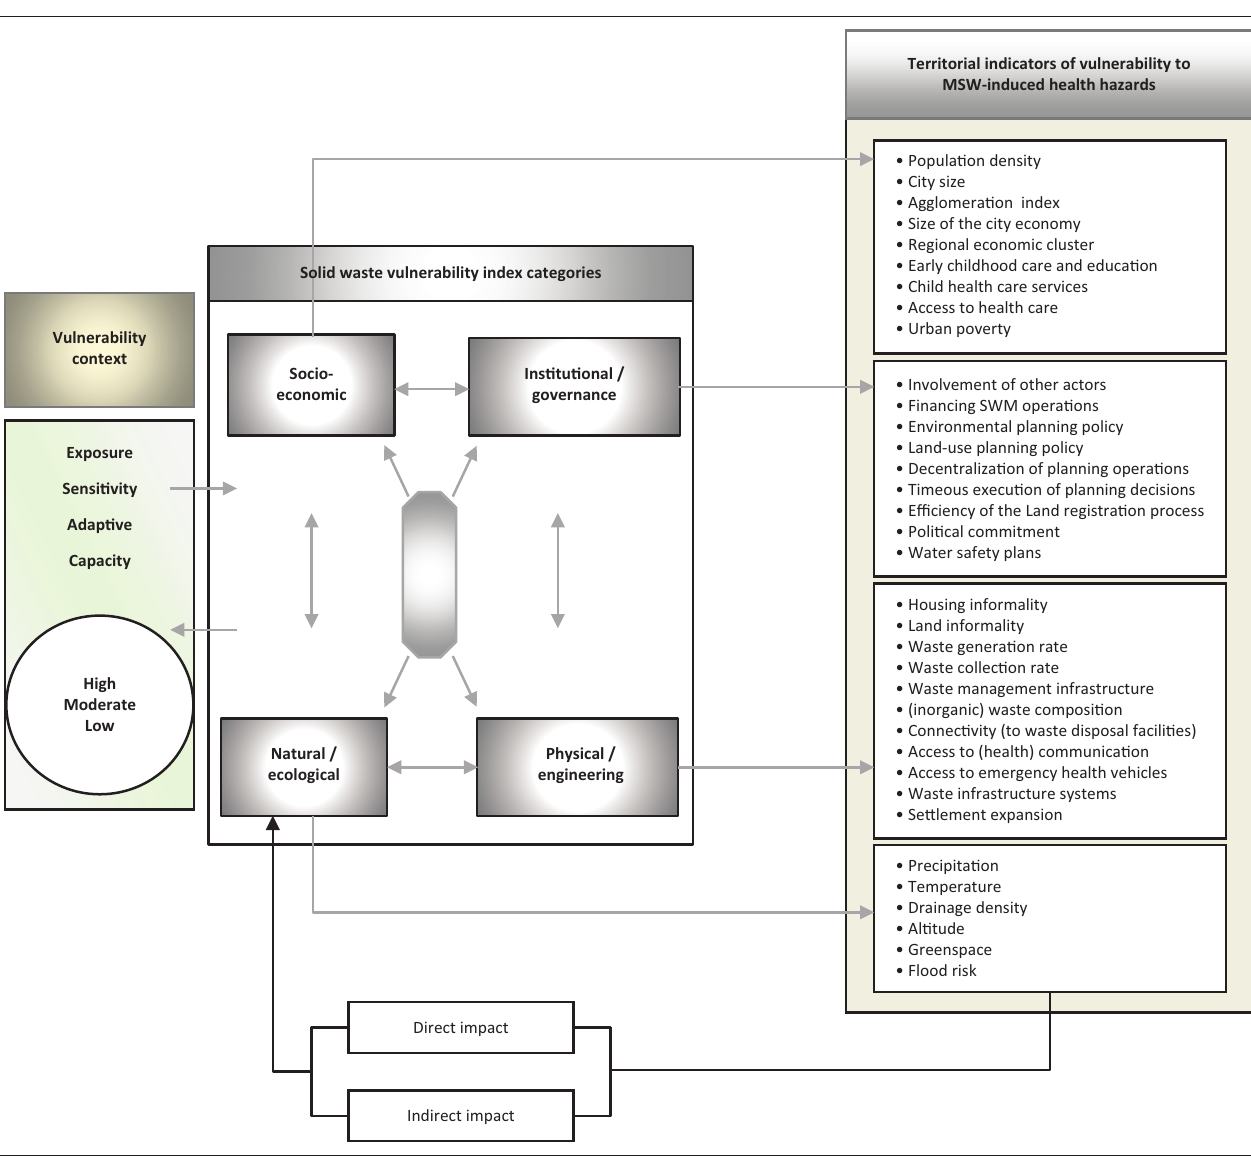
FIGURE 1: The proposed municipal solid waste management vulnerability assessment